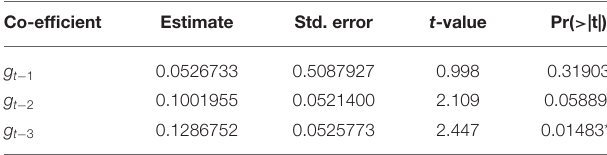
TABLE 6 | VAR Model Estimates for G-price with dollar exchange rate during COVID-19 period. Co-efficient Estimate Std. error